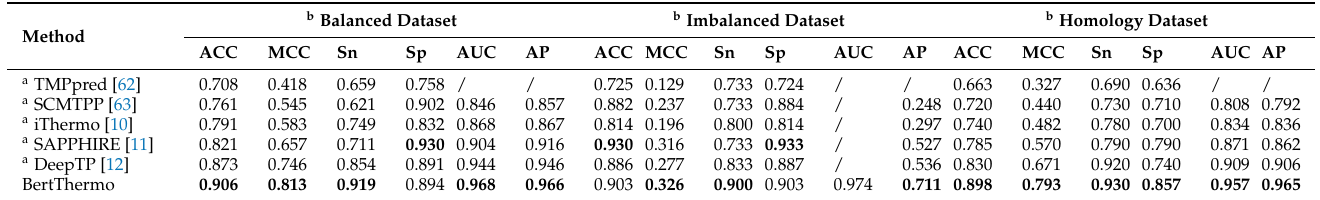
Table 6. Comparison with state-of-the-art methods with various independent datasets. b Balanced Method